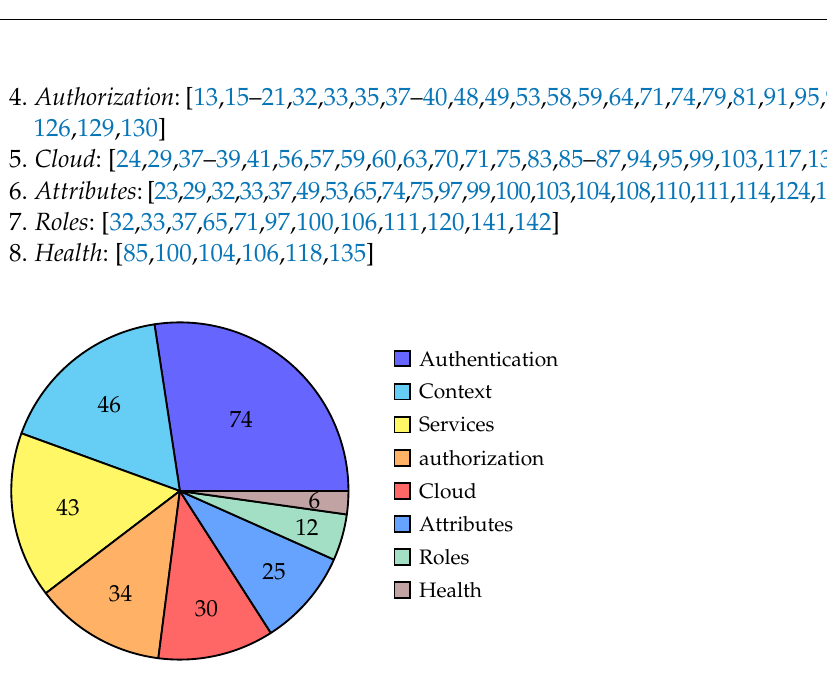
Graph. 2. Number of articles in each category. Figure 3. Number of articles in each